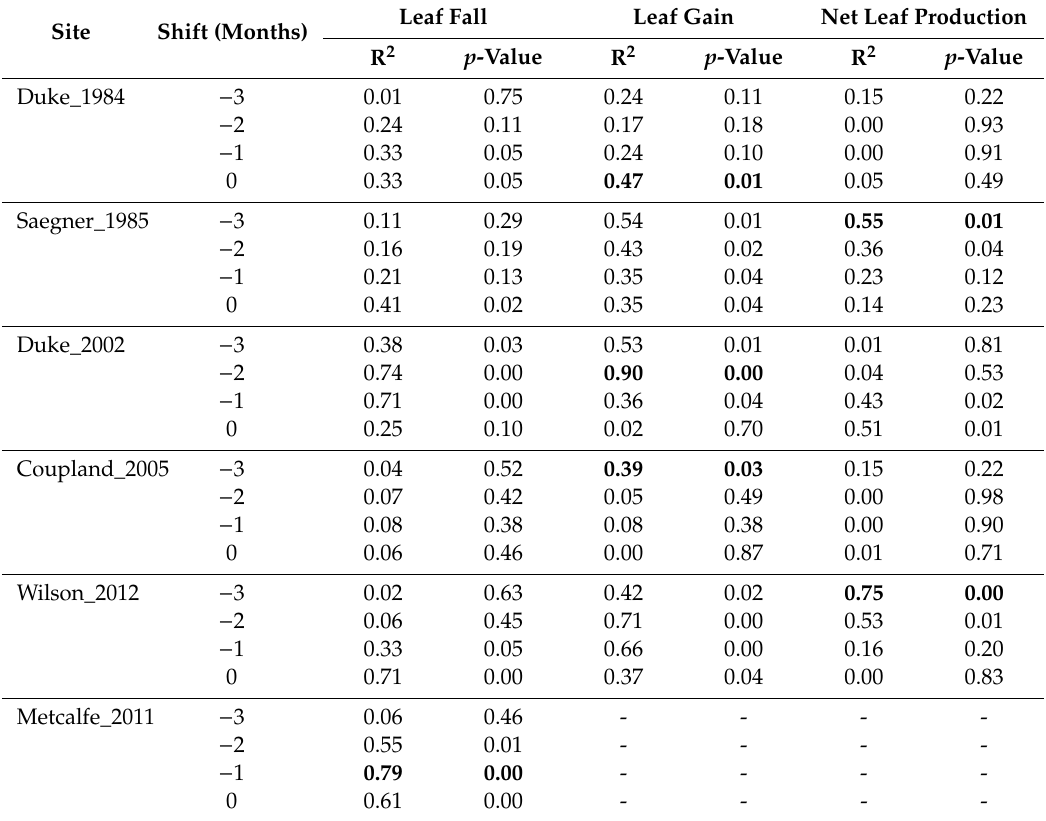
Table 4. Correlation coe ffi cients of the apparent phenology versus net leaf production, leaf fall and leaf gain for each site. Highest R 2 values per site are shown in